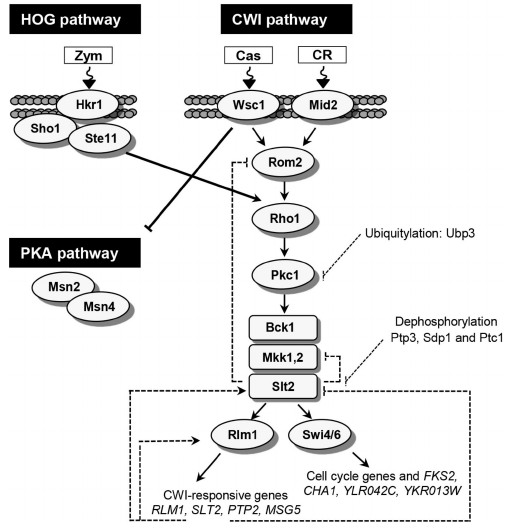
Figure 1. The cell wall integrity (CWI) signaling pathway. Cell wall damage is sensed (wave arrows) at the plasma membrane through cell-surface proteins that stimulate nucleotide exchange on Rho1 and activation of Pkc1. The main role of activated Pkc1 is to trigger the MAPK module (Bck1, Mkk1/Mkk2 and Slt2). Once phosphorylated, the MAPK Slt2 activates two different transcription factors, SBF (Swi4/Swi6) and Rlm1. Cell wall damage caused by Congo red (CR) is sensed mainly through Mid2 to activate the CWI pathway; Zymolyase (Zym) mediated cell wall stress requires Hkr1 sensor and elements of the Sho1 branch of the high-osmolarity glycerol (HOG) pathway to activate Rho1; Caspofungin (Cas) is sensed through Wsc1 leading to the activation of the CWI pathway and parallel inhibition of protein kinase A (PKA) signaling (solid lines) Modulatory mechanisms of CWI signaling are represented with broken lines. Rlm1 elicits transcriptional positive feedback loops on the expression of RLM1 and SLT2 . In contrast, attenuation of the CWI pathway requires negative retrophosphorylation feedback loops mediated by Slt2 on Rom2 and Mkk1/2 and the Rlm1-dependent transcriptional induction of the Slt2 phosphatases Ptp2 and Msg5. In addition, other Slt2 phosphatases like Ptp3, Sdp1 and Ptc1 and ubiquitination of Pkc1 by Ubp3 also contribute to attenuate the induction of CWI pathway. Arrows and T symbols represent activation (positive) and inhibitory (negative) events,